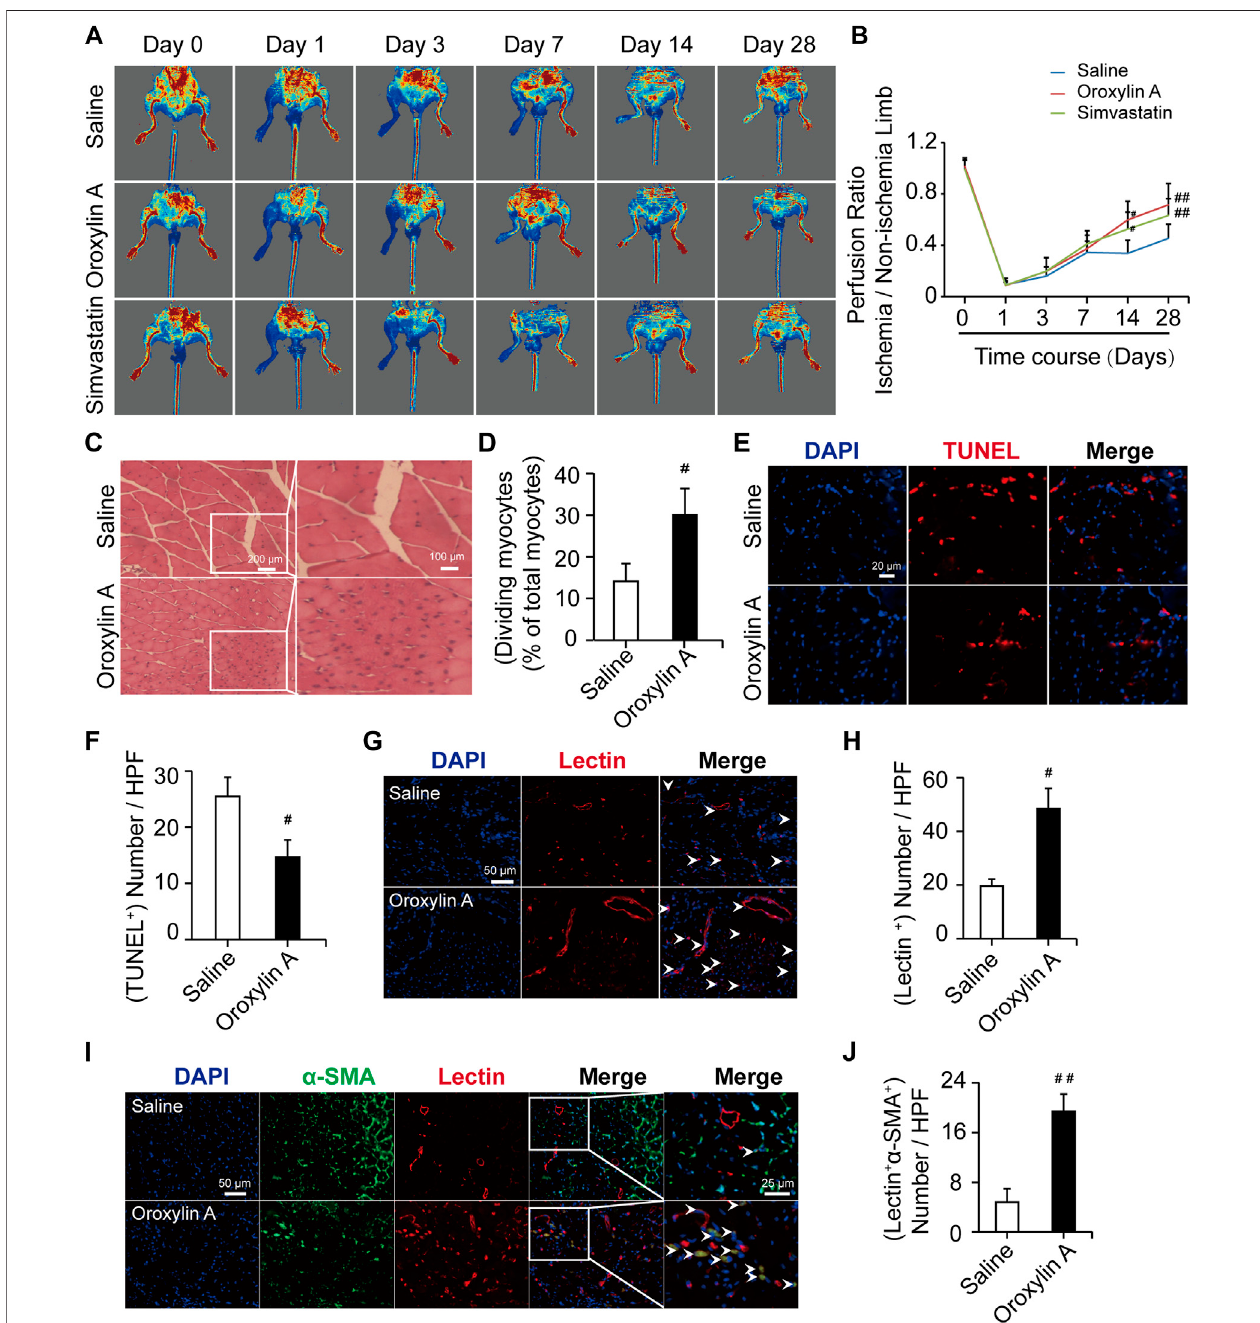
FIGURE1| OAamelioratedhindlimbischemiainamousemodelofHLI. (A) Typicalblood fl owperfusionphotographsatdifferenttime(pre-andpost-operatively,as well as 3, 7, 14, and 28 days after excision of the femoral artery) in three groups were presented. (B) Quanti fi cation of blood perfusion at different times was performed. Dataare mean ± SD; n (cid:2) 5 – 8/group. (C,D) H and Estainingof muscle tissue in hindlimb con fi rmed the number ofmyocytes with centrally-located nuclei were increased by OA therapy. The scale bar represented 200 μ m (left) and the scale bar represented 100 μ m (right). (E,F) TUNEL staining was used for detecting apoptosis (red) ofmyocytes and DAPI(blue) wasfornuclear staining.OAcould signi fi cantlyreduce themyocytes apoptosis. The scalebar represented 20 μ m. Dataaremean ± SD; n (cid:2) 3 – 4/group. (G) Representative immuno fl uorescent images were presented to determine capillary density in ischemic muscles on day 28. Capillaries were stained with lectin (red) and nuclei were stained with DAPI (blue). The white arrowheads showed the region of blood vessels. The scale bar represented 50 μ m. (H) Quanti fi cation of capillary density was expressed as lectin positive number per randomly chosen high-power fi eld (HPF). n (cid:2) 3/group. (I) Capillaries were stained with lectin (red), α -SMA (green), and nuclei were stained with DAPI (blue). The white arrowheads showed the region of mature, functional blood vessels. The scale bar represented 25 μ m. (J) Quanti fi cation of the mature, functional blood vessels in the adductor muscle was expressed as lectin, α -SMA double-positive number per randomly chosen HPF. Data are mean ± SD; n (cid:2) 5/group, # p < 0.05, ## p < 0.01 vs . saline.